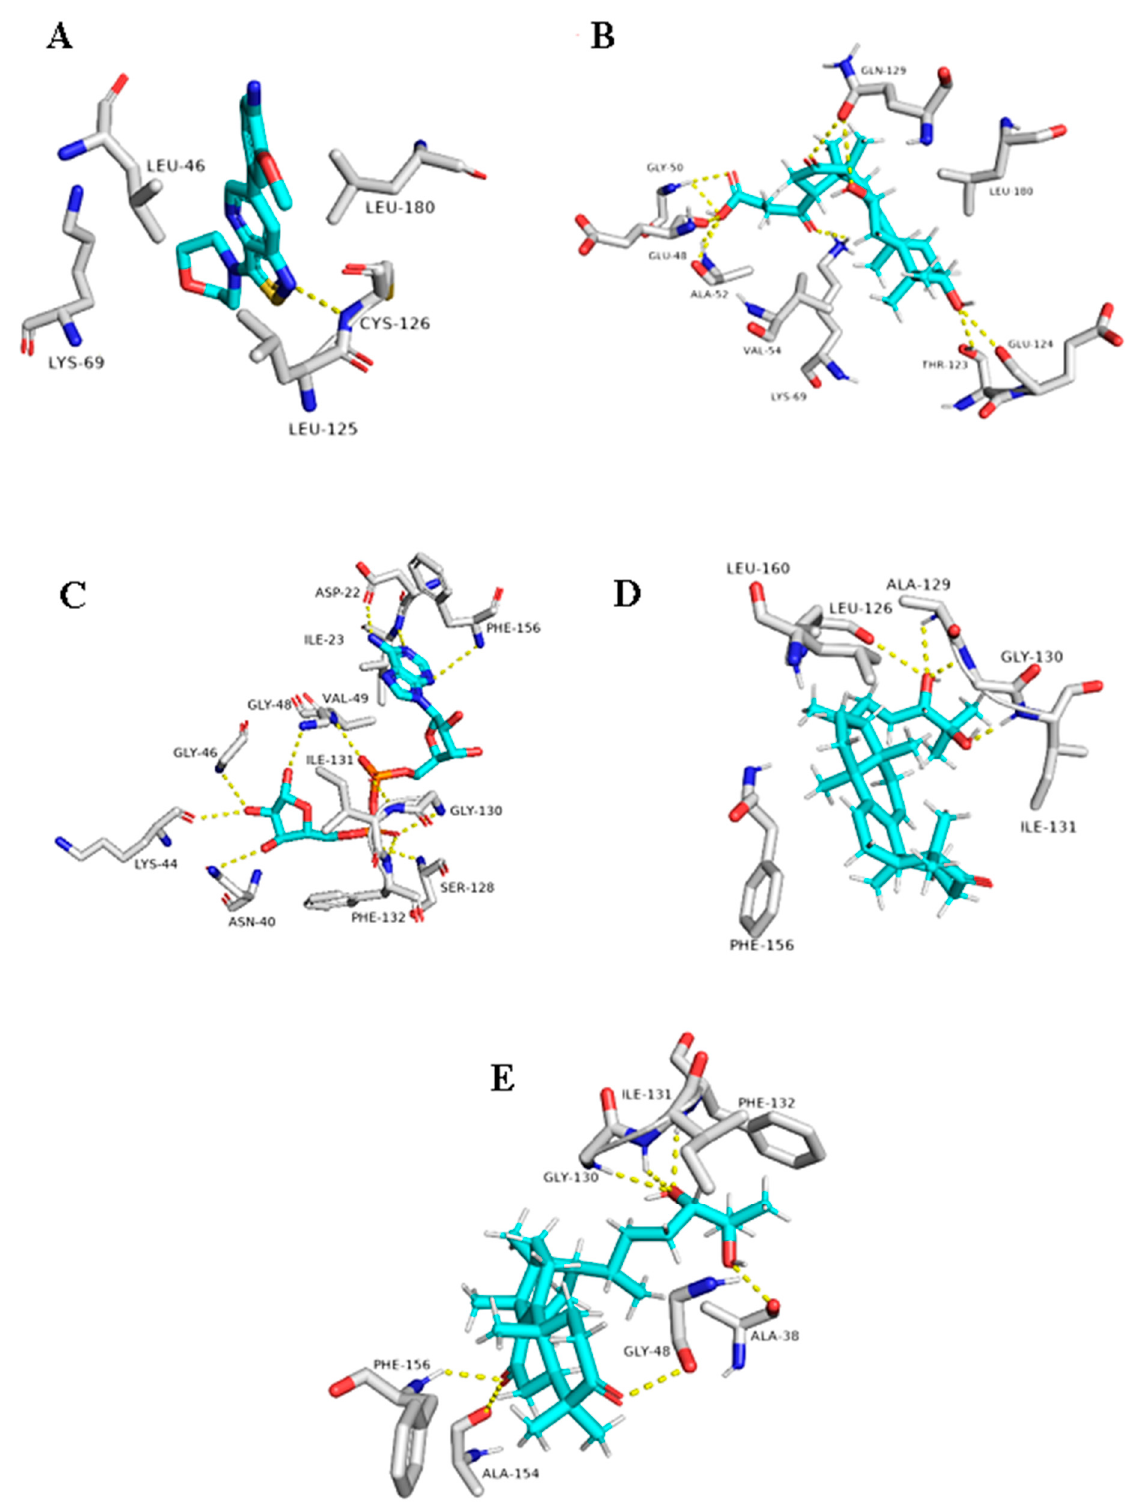
Figure 12. Binding modes of 20(21)-dehydrolucidenic acid ( B ) (12), Ganodermanondiol ( D ) (13), and Lucidumol A ( E ) (15) inside the viral and human-based targets (GAK and ARP, respectively). ( A , C ) co-crystallized ligands of GAK and ARP, respectively.